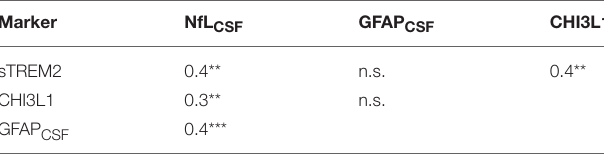
TABLE 3 | Correlations between various CSF